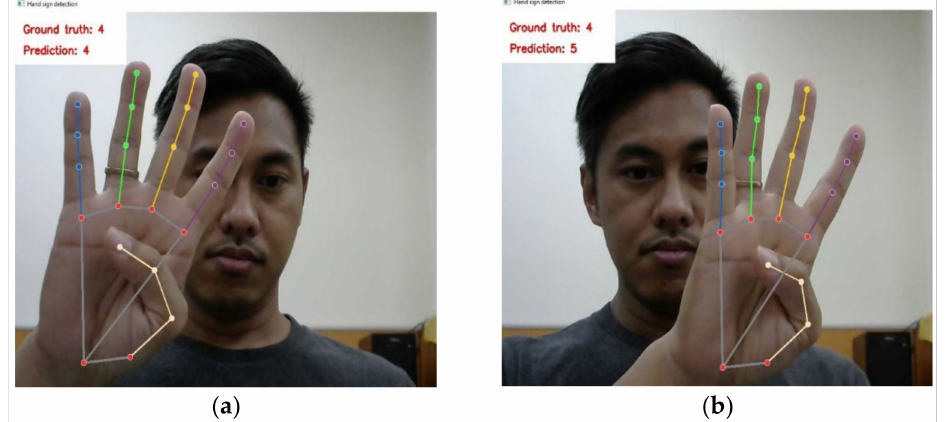
Figure 8. Prediction result using Dataset 2 and 10 features: ( a ) correct prediction; ( b ) incorrect prediction.